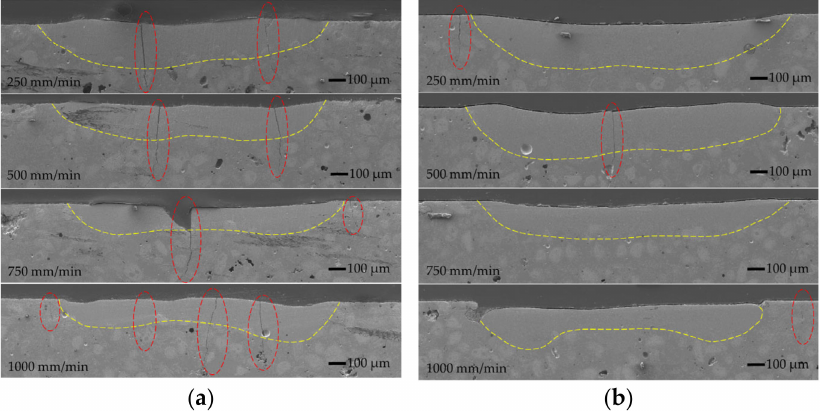
Figure 3. Cross-sectional SEM micrographs of non-oscillated molten pools obtained without ( a – d ) and with ( e – h ) preheating and a varying laser operating speed between 250 and 1000 mm/min.